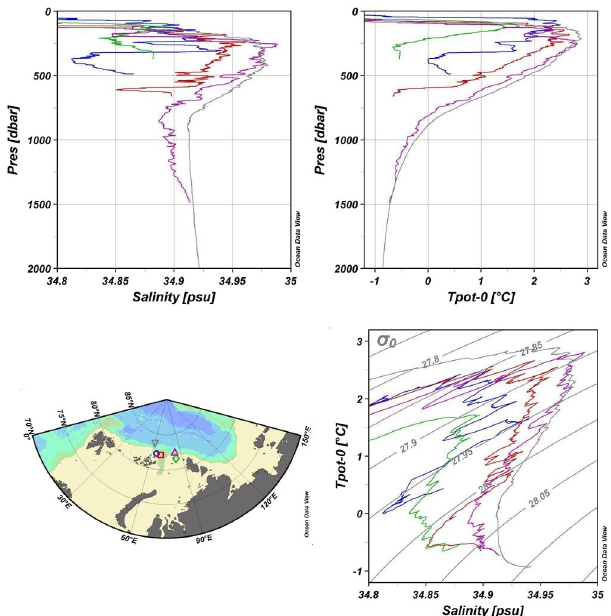
Fig. 9 . Profiles of salinity and potential temperature and θS curves from the shelf and slope in the eastern Kara Sea. The three dense contributions from the Barents Sea are seen as a temperature maxi- mum, a salinity and a temperature minimum, and a cold, more saline bottom water. The magenta station shows strong isopycnal mixing between the two branches. On the slope Barents Sea branch water that has entered the deep basin directly from the St. Anna Trough is seen as a low salinity layer (grey and yellow stations). The intru- sions in the Fram Strait branch are found at the temperature maxi- mum but above the salinity